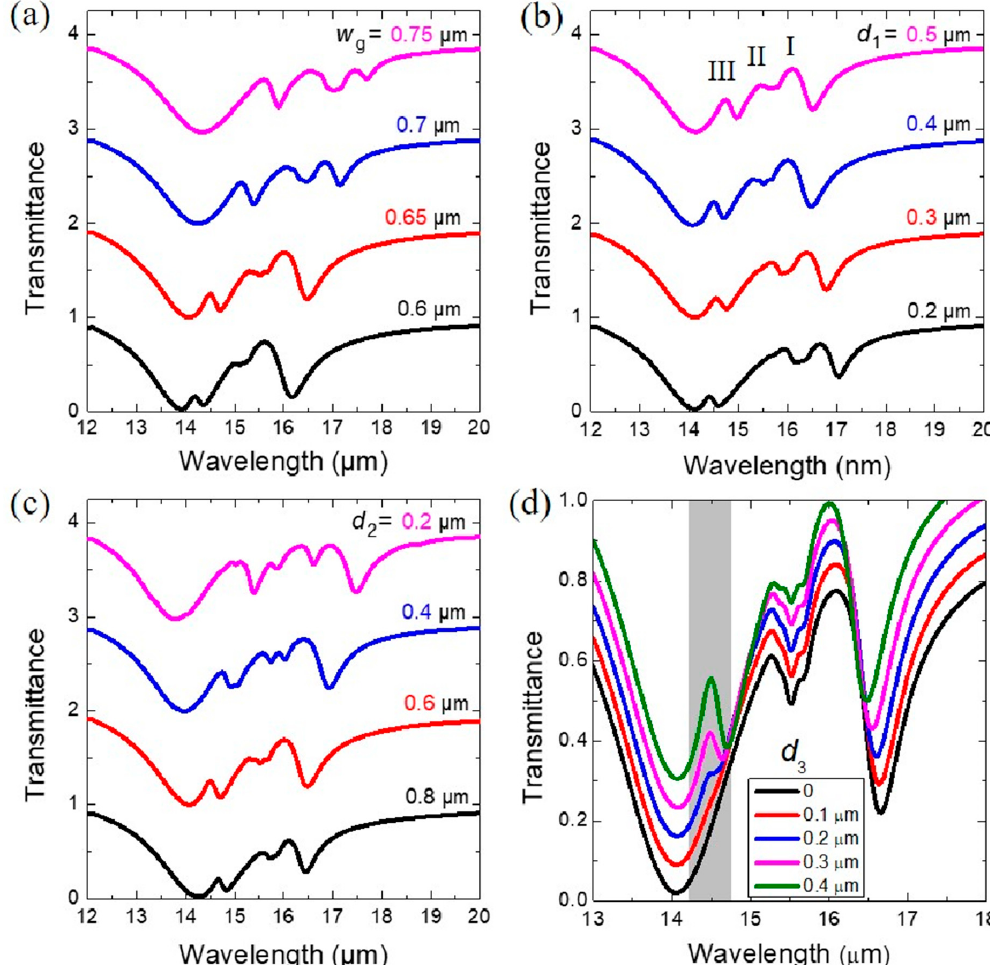
Figure 4. The normal-incidence transmittance of the hybrid structure with various ( a ) widths ( w g ) of the GNR, ( b ) gap sizes ( d 1 ) of the GNRD, ( c ) vertical distances ( d 2 ) between the GNRD and gold SRR, and ( d ) offsets ( d 3 ) between the geometrical centers of the GNRD and the gold SRR along the x axis.